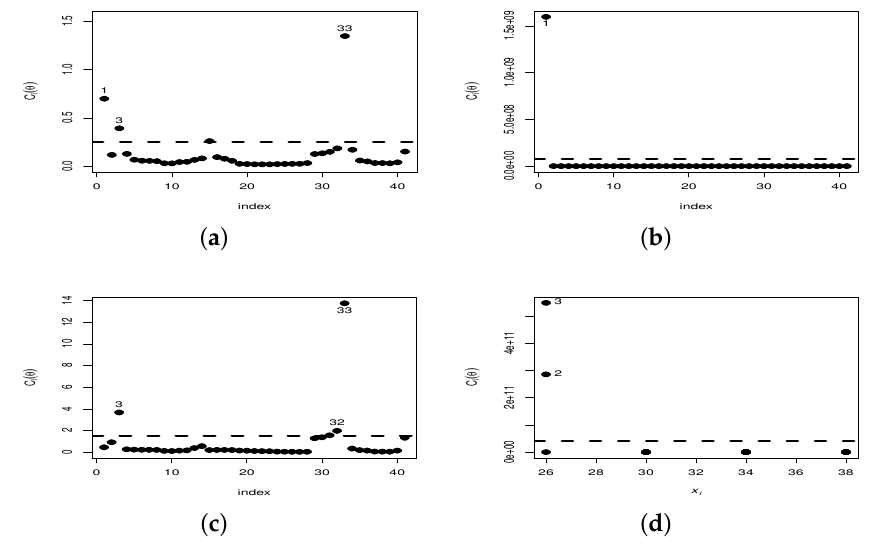
Figure 5. Index plots of C i ( θ ) under case-weight perturbation ( a ), response perturbation ( b ), per- turbation of the parameter k ( c ), and covariate perturbation X ( d ) for the data of time to electrical breakdown of an insulating fluid and the Weibull quantile